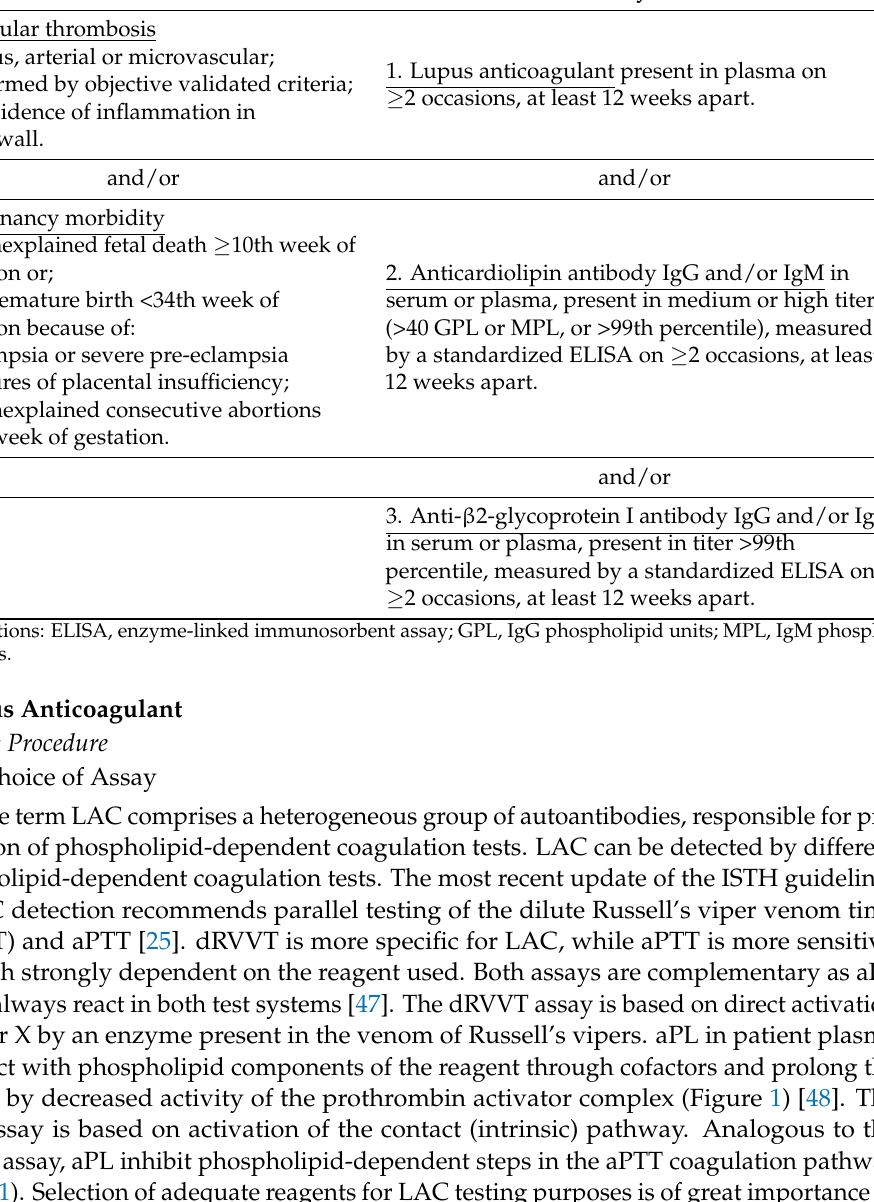
Table 1. Sydney criteria (2006) for classification of antiphospholipid syndrome. Clinical